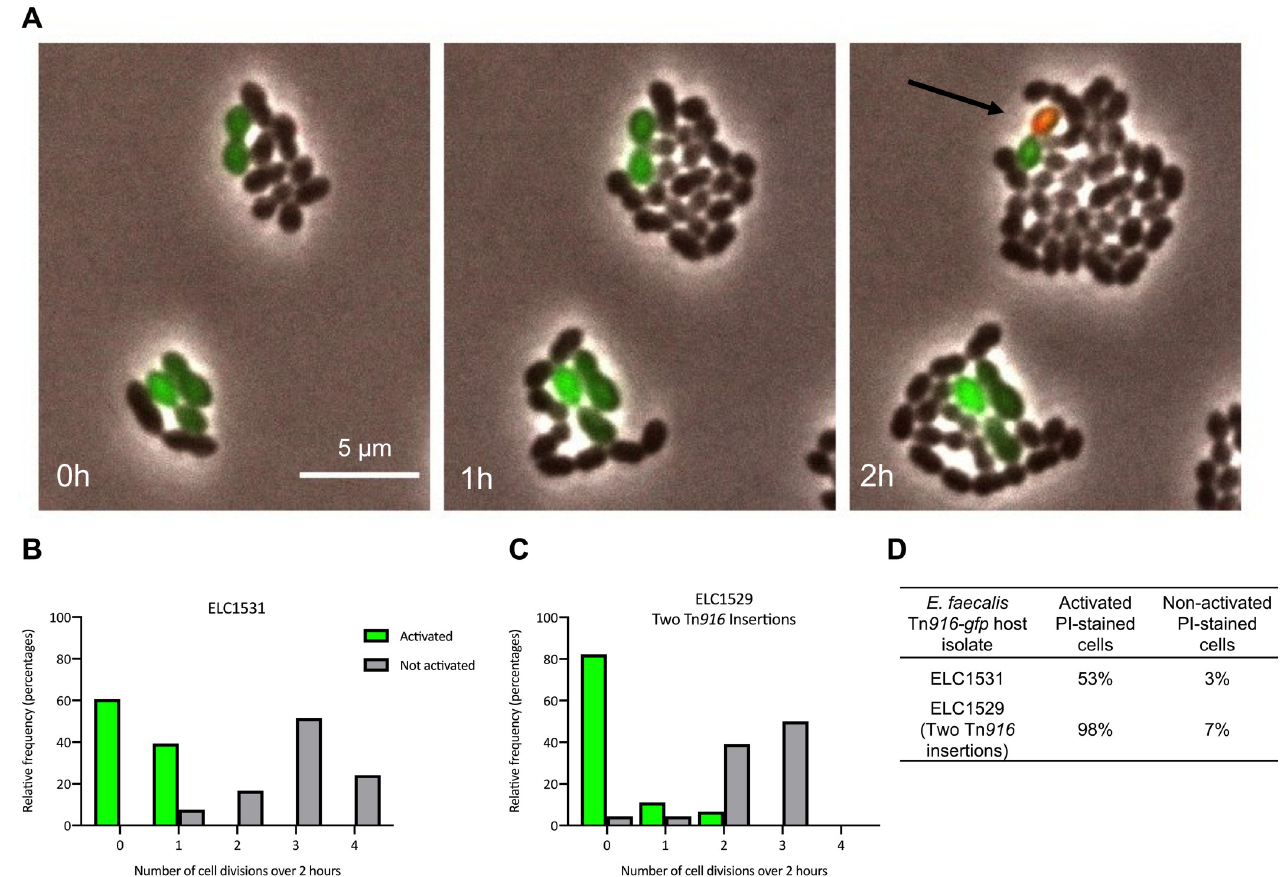
Fig 8. Activation of Tn 916 causes growth arrest and cell death in E . faecalis . Two separate isolates of E . faecalis containing Tn 916 - gfp were used to monitor effects of Tn 916 activation. E . faecalis strains ELC1531 and ELC1529 have one and two copies of Tn 916-gfp , respectively (see Materials and Methods). Cells were grown in a rich M9 medium (Methods) to late exponential phase with 2.5 μ g/ml tetracycline to stimulate Tn 916 excision. At time = 0 h, cells were spotted on M9 medium agarose pads containing 2.5 μ g/ml tetracycline, 0.1 μ M propidium iodide, and 0.5 μ g/ml DAPI. Cells were monitored by phase contrast and fluorescence microscopy for two hours. A) A representative set of images monitoring ELC1531 cells with an activated copy of Tn 916 - gfp (GFP-positive). Similar results were observed with ELC1529. The black arrow in the final frame indicates a PI-stained, GFP-positive cell (appears reddish-yellow). B,C) Histograms displaying the relative frequency (percentage) of Tn 916 - gfp activated (GFP-positive) cells that underwent the indicated number of cell divisions, compared to non-activated (GFP-negative) cells for each isolate. Sixty-six activated (GFP-positive) and 66 non-activated (GFP-negative) cells for ELC1531 and 45 of each for ELC1529 were monitored. D) The frequency of cells that stained with PI (indicating cell death) or had a daughter cell become PI-positive was determined for both activated and non-activated cells during the 2-hour time